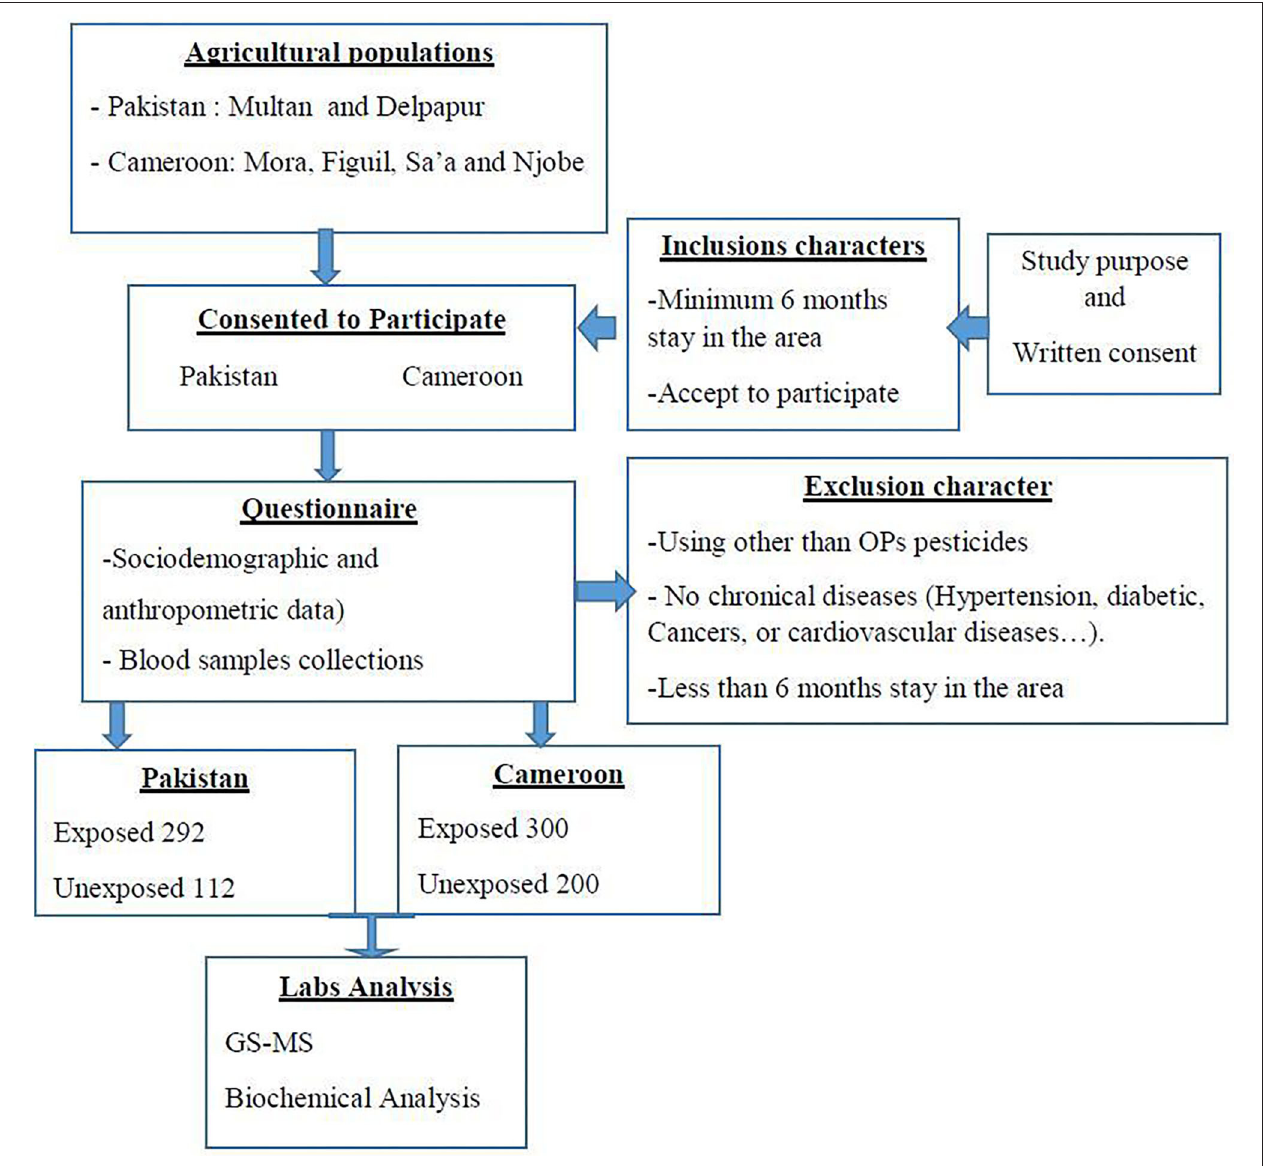
FIGURE 2 | Schematic representation of